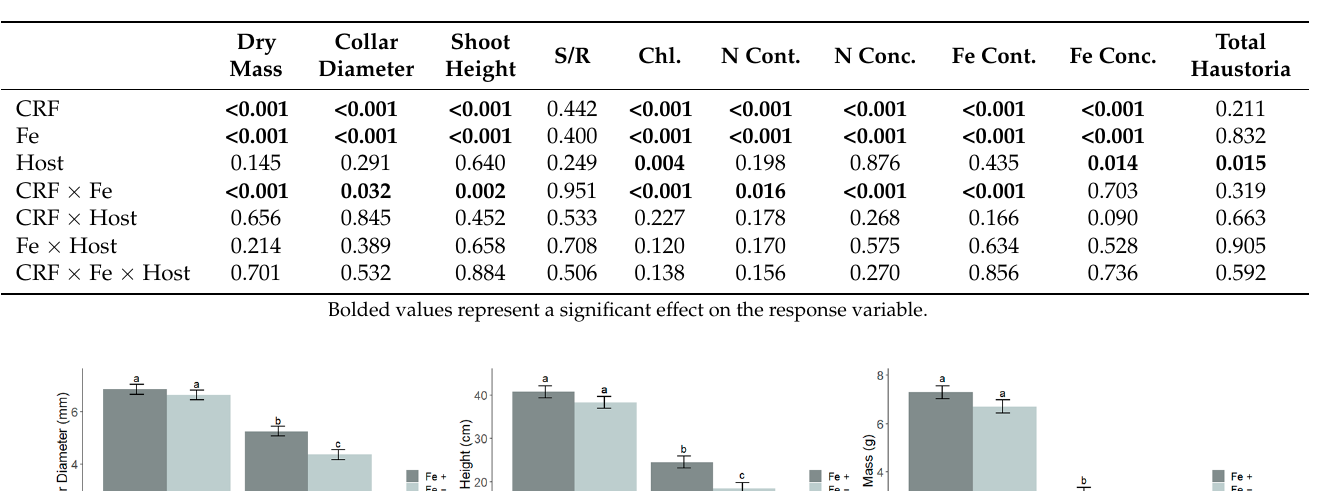
Table 1. The p values resulting from a three-way ANOVA performed on mixed effect models fitted for each response variable. CRF = controlled-release fertilizer; Fe = chelated iron fertilizer; S/R = shoot/root ratio; Chl. = chlorophyll index.